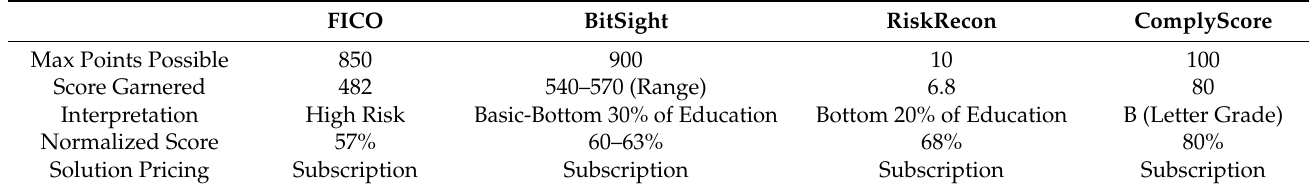
Table 2. Comparison of summary of results for the University at